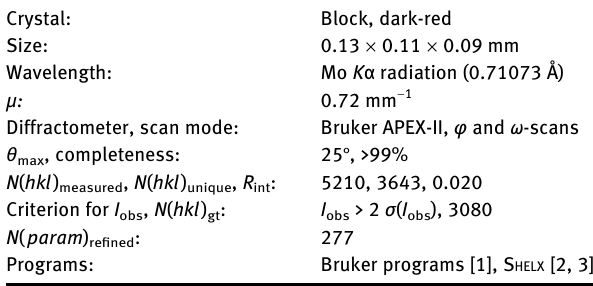
Table 1 contains crystallographic data and Table 2 con- tains the list of the atoms including atomic coordinates and displacement parameters.